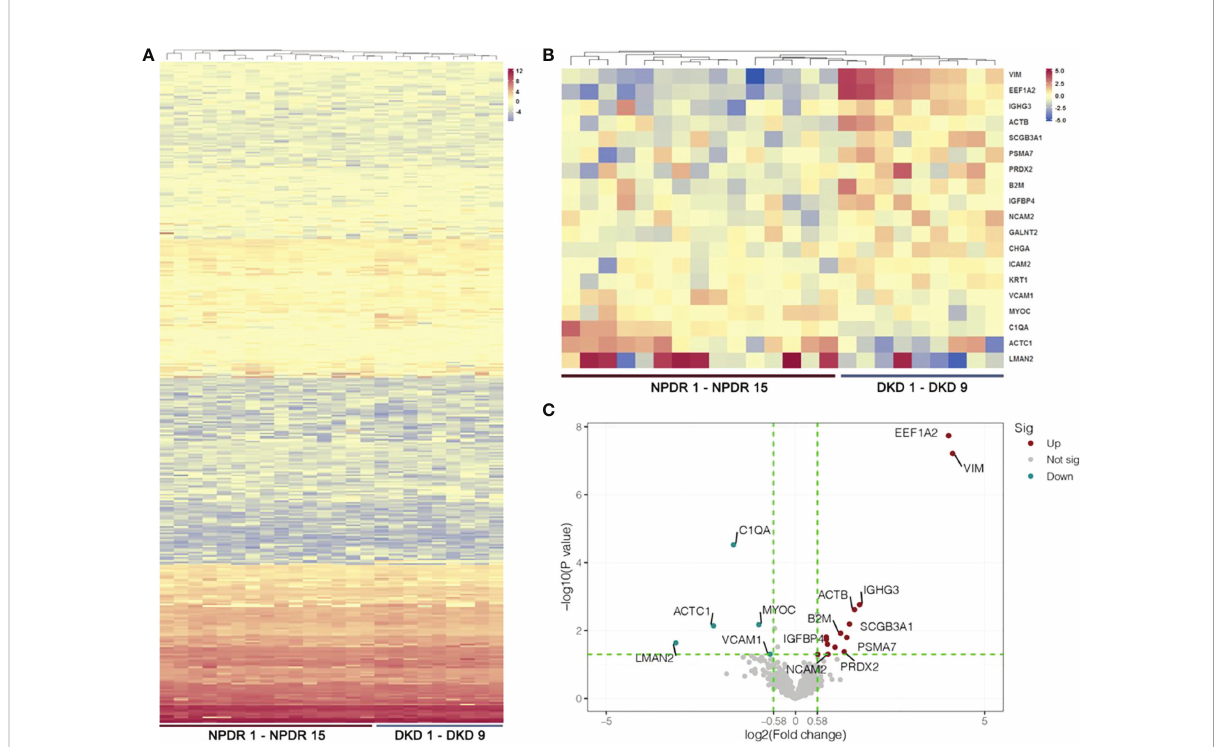
FIGURE 2 Heatmap and volcano plot of DEPs. (A) Hierarchical cluster analysis of all detected proteins in the NPDR and NPDR+DKD (DKD) groups. (B) Heatmap showing DEPs between the DKD and NPDR groups. (C) The volcano plot represents the DEPs with P<0.05 and FC>1.5 with red and green colors. Red dots show the upregulated proteins, green dots represent the downregulated proteins, and gray dots indicate that the proteins were not signi fi cantly up- or downregulated between the DKD and NPDR groups. (n = 15 in NPDR group; n = 9 in DKD